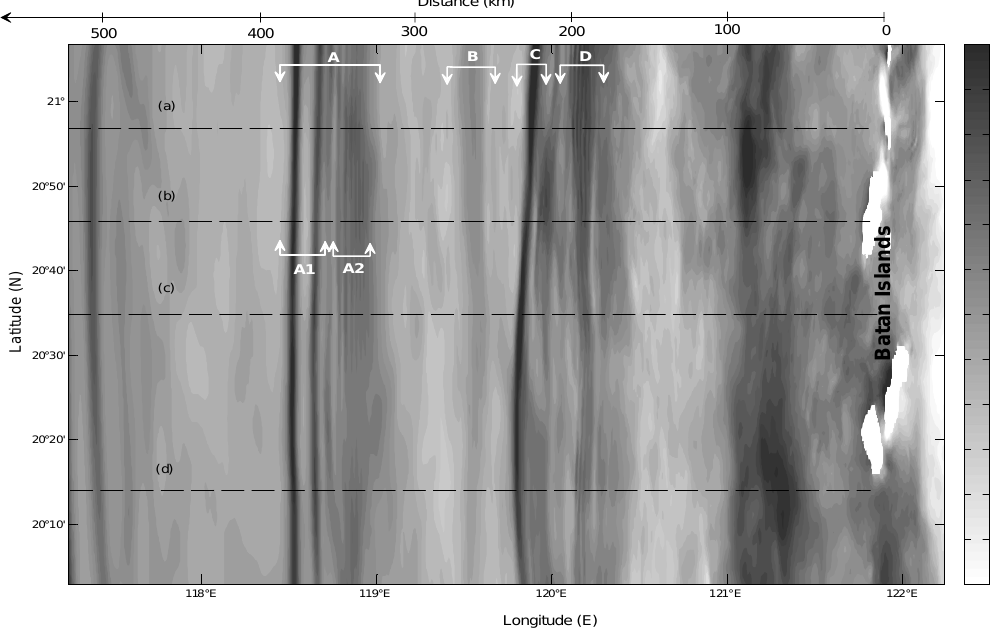
Fig. 3. Model-predicted sea surface elevations produced by internal waves generated at the Luzon Strait and propagated westward. The axis at the top shows an actual coordinate system used in Figs. 4, 7 and 8. Wave structures marked as C and D correspond to the similar fragments II and III shown in Fig. 7h.